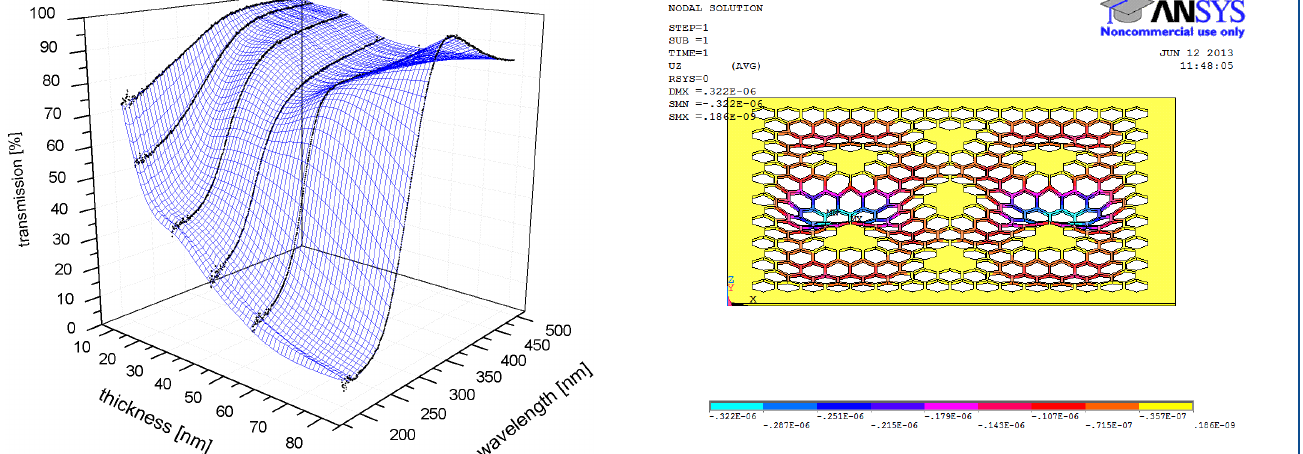
Figure 9. Deformation of a TiN grid structure with supporting ele- ments by maximum electrostatic